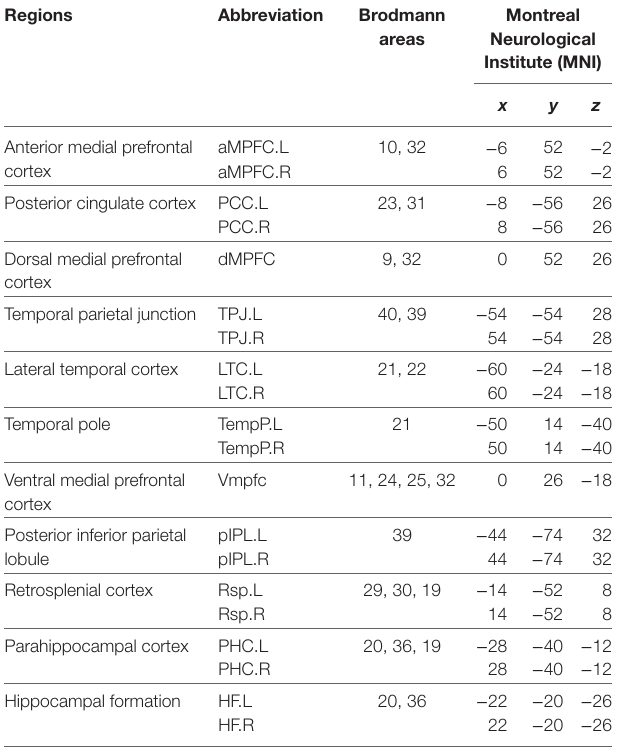
Table 1 | Regions of interest within the default mode network